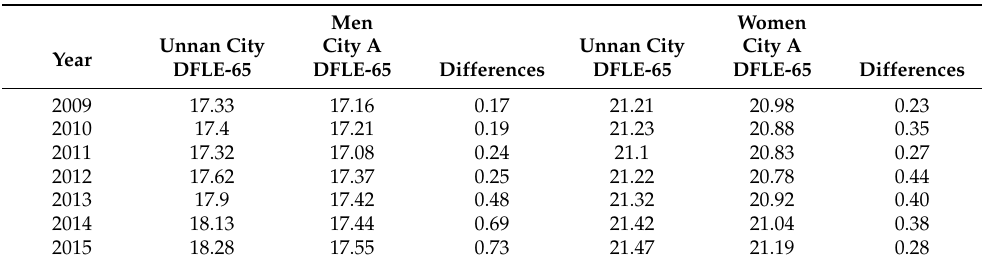
Table 2. Disability-free life expectancy from 65 years of age (DFLE-65) differences between Unnan City and City A.